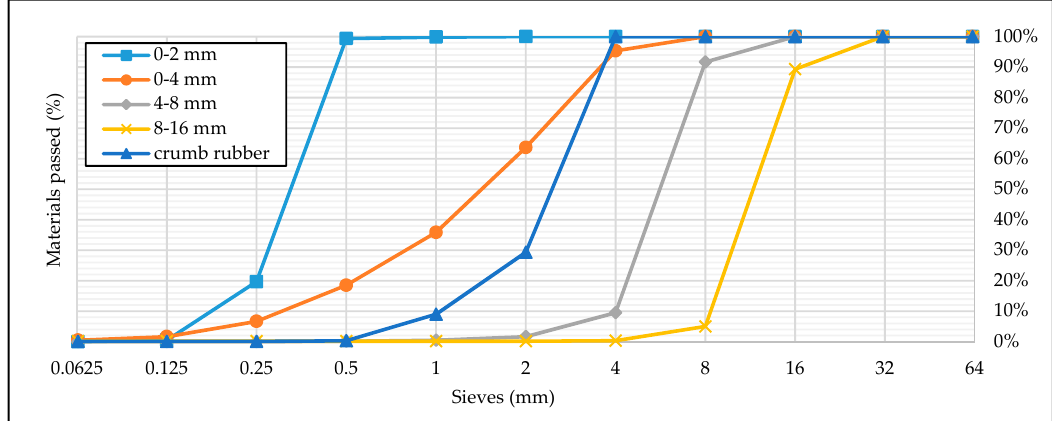
Figure 2. Sieve analysis of fine aggregate, coarse aggregate, and crumb rubber.